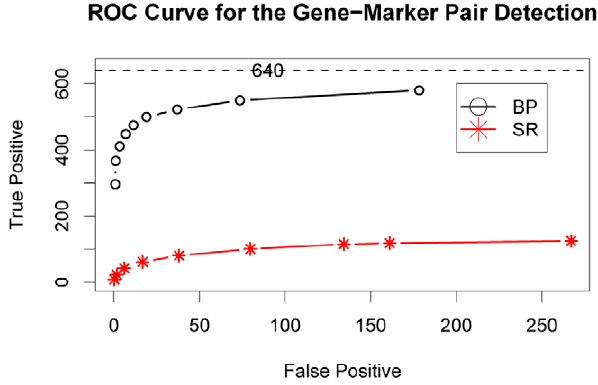
Figure 3. Comparison of the receiver operator characteristic (ROC) curves for the gene-marker pair detection obtained by our Bayesian partition method (BP) and the two-stage regression method (SR). Different points along the ROC curves represent the false positive and true positive counts averaged over 100 simulations at different posterior probability thresholds (for BP) or at different FDR thresholds (for SR). There are 40 genes in each of the eight modules which are linked to two markers and thus the total number of the true positive gene-marker pairs is 640. doi:10.1371/journal.pcbi.1000642.g003 PLoS Computational Biology |